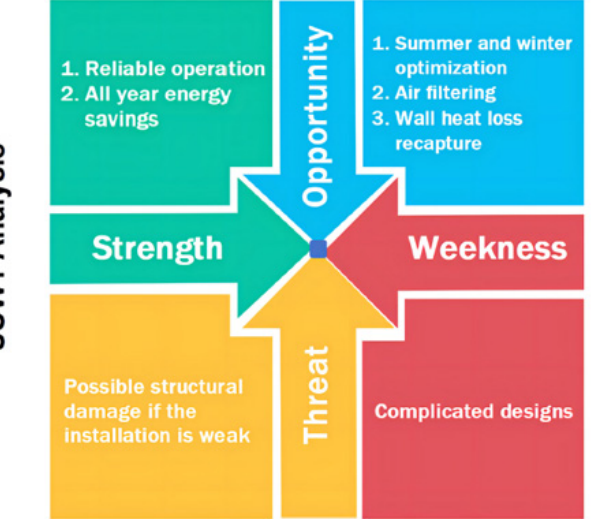
Figure 38. SWOT analysis for the dynamic insulation approach [11]. SWOT strengths, weaknesses, opportunities, and threats analysis.